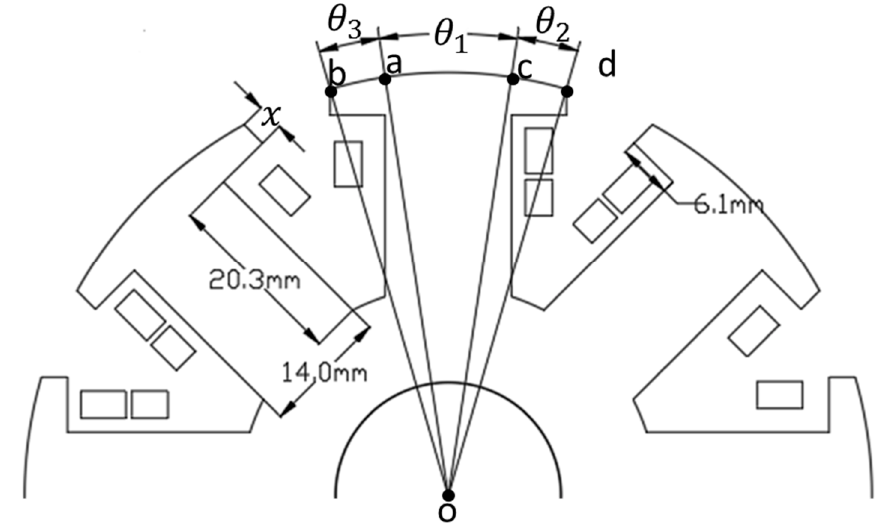
Figure 8. Rotor structure with design variables (basic model).